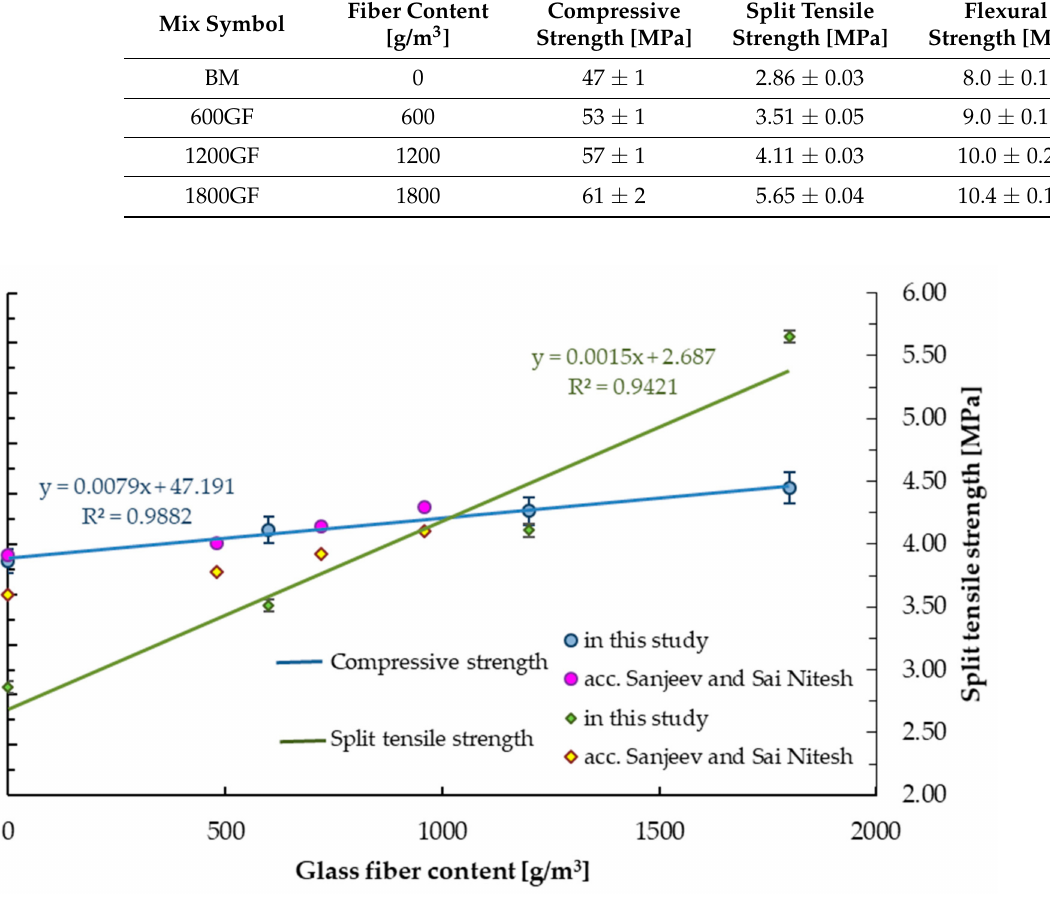
Figure 7. Compressive and split tensile